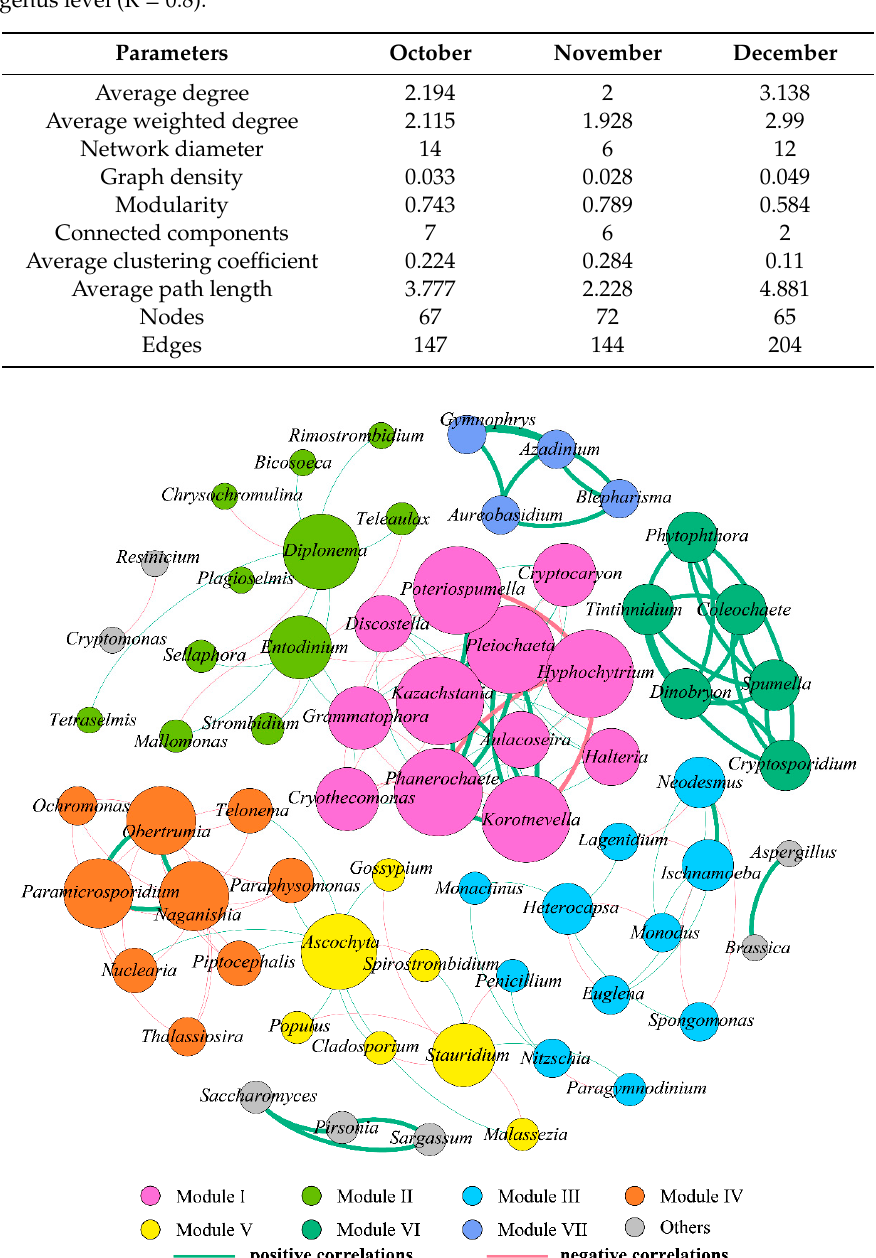
Figure 8. Coexistence and interaction of eukaryote community compositions at the genus level based on the 18S rRNA sequence and associated with a water sample in October 2018. The nodes were colored according to modularity class. Each node represents one individual eukaryotic species. The larger the node is, the more connections it has to other nodes. The green lines signify positive correlations, while the red lines signify negative correlations.